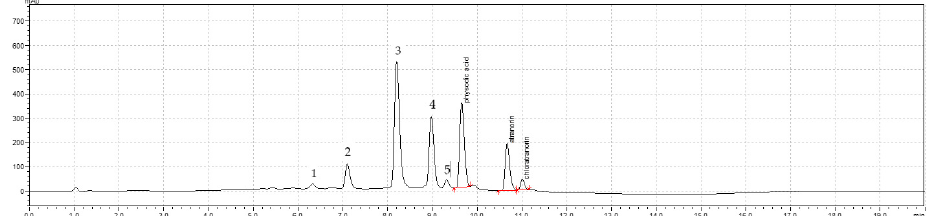
Figure 6. The chromatogram of extract from Hypogymnia physodes . Physodic acid, atranorin and chloroatranorin are identified in the extract. Compounds 1, 2, 3, 4 , and 5, are characterized by t R =